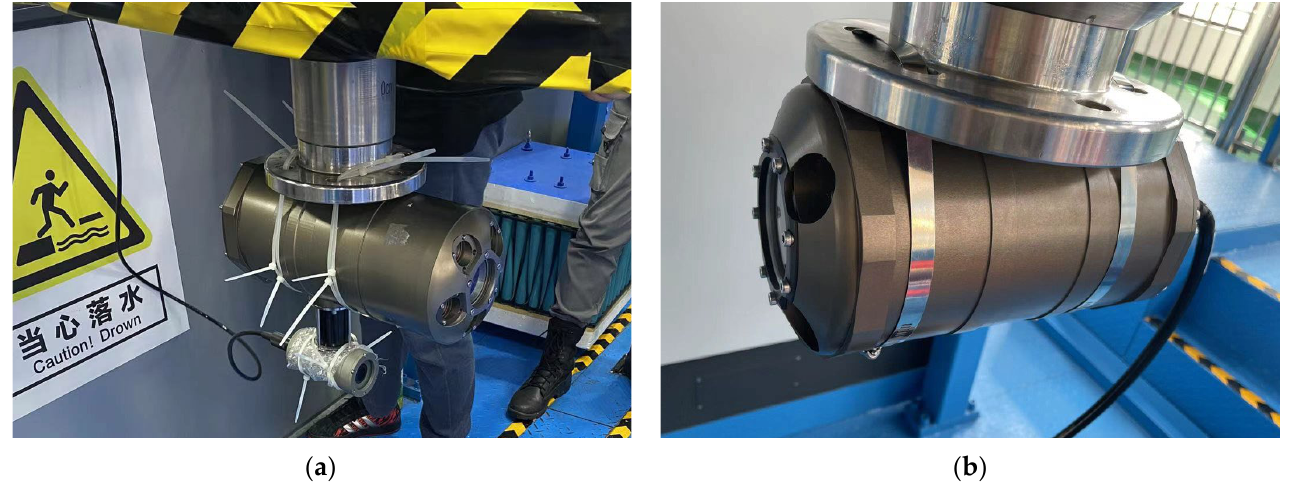
Figure 3. Device installation diagram: ( a ) The detection device is fixed to the lift bar and drops to 3 m underwater; ( b ) The device to be tested is fixed to a lift rod on the other side and lowered to 3 m underwater.